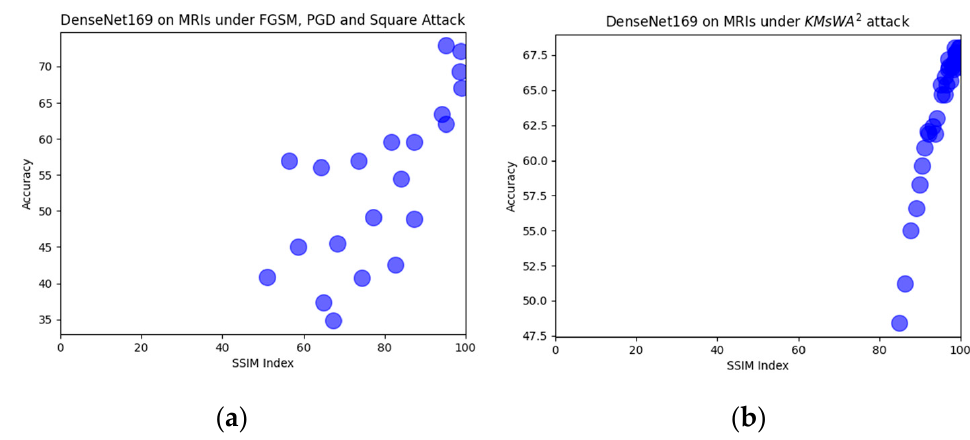
Figure 12. Scatter plots for DenseNet169 in MRIs under ( a ) FGSM, PGD, Square Attack, and ( b ) KMsWA 2 attack.